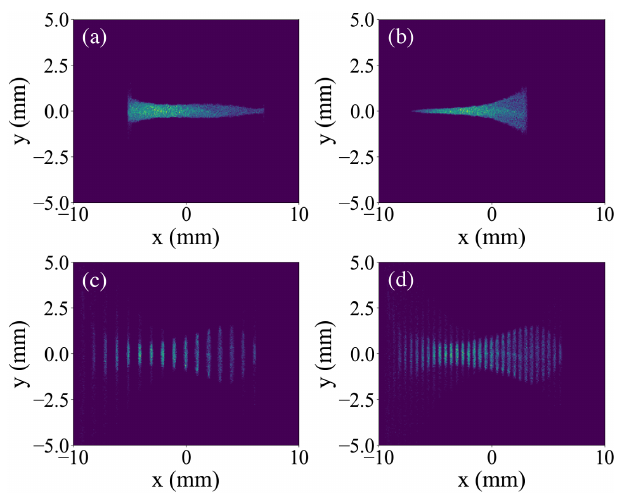
FIG. 13. Beam images after the mask for various profiles in Fig. 6: (a) doorstep, (b) reverse triangle, (c) comblike bunch, and (d) comblike bunch with a higher